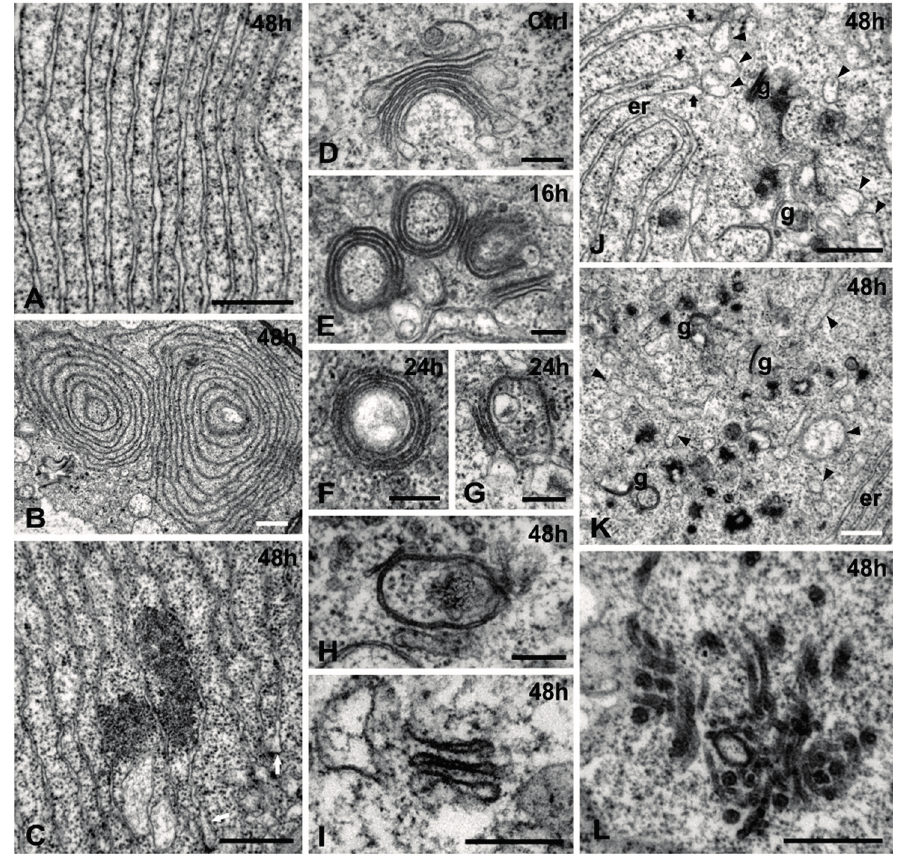
Figure 5. Cr(VI) effects on the endomembrane system of A. thaliana . ( A – C ) 48 h Cr(VI) treatment, effects on the ER. A bundle of parallel straight ER cisternae ( A ) and concentric conformations of ER ( B ). Amorphous electron dense material in the inter-cisternal spaces of ER and some bulging edges (arrows) ( C ); ( D – I ) Cr(VI) effects on the Golgi apparatus; ( D ) Control; ( E ) 16 h Cr(VI) treatment. Golgi bodies with circular or semi-circular conformation. ( F , G ) 24 h Cr(VI) treatment. A Golgi body with circular cisternae and translucent enclosure ( F ) and one with reduced cisternae ( G ); ( H , I ) 48 h Cr(VI) treatment. Two degenerated Golgi bodies with a cyclic cisterna ( H ) and slightly dilated short cisternae ( I ); ( J – L ) 48 h Cr(VI) treatment; ( J , K ) Accumulation of Golgi remnants (g) and helical or elongate vesicles (arrowheads). Some vesicles seem to bulge from the edges of ER (er) cisternae (arrows); ( K ) Cytoplasmic area dominated by vesicles, vesicular cisternae, remnants of Golgi bodies and amorphous dense material; ( L ) A clustering of tubular and vesicular structures with dense contents. Scale bars: ( A , C , J – L ): 0.5 μ m; ( B ): 1 μ M; ( D – I ): 0.2 μ m. Mitochondria of untreated cells were pheiomorphic, delimited by a clearly discernible double membrane envelope and containing numerous cristae in a dense stroma (Figure 6A). In Cr(VI)-treated cells mitochondria progressively exhibited oval to spherical shapes, lost their cristae and exhibited translucent to transparent stroma (Figure 6B–D). In moderate treatments (16, 24 h) affected